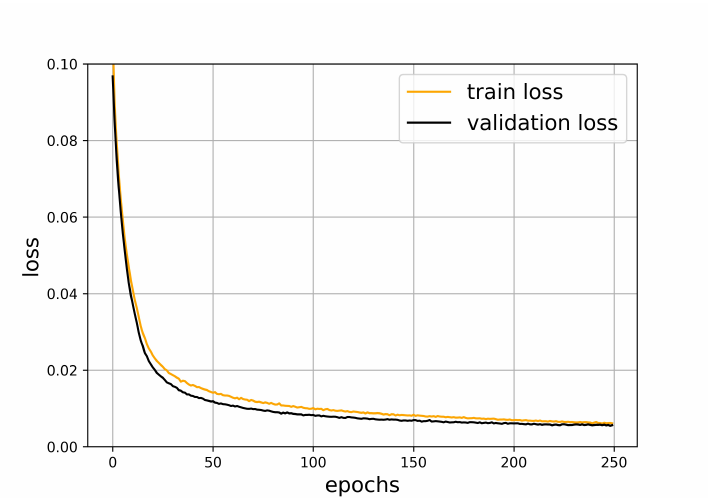
Figure 13. Train and validation loss for preprocessed simulation data with a conventional convolution